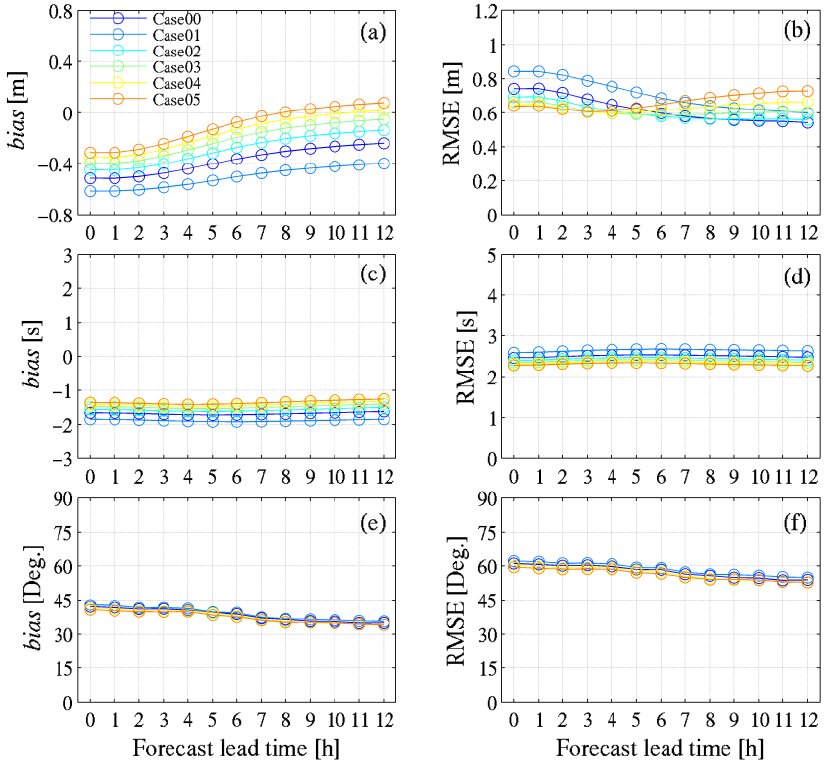
Figure 6. ( a ) bias and ( b ) root mean square error (RMSE) of significant wave height; ( c ) bias and ( d ) RMSE of the wave period; ( e ) bias and ( f ) RMSE of the wave direction for each forecast lead time according to β max settings (Case00: β max = 1.65, Case01: β max = 1.15, Case02: β max = 2.05, Case03: β max = 2.45, Case04: β max = 2.85, Case05: β max = 3.25).